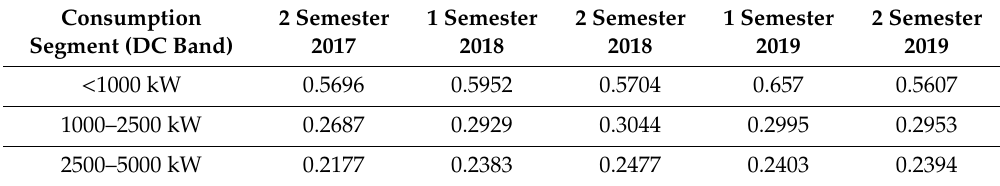
Table 4. Residential electricity prices in Spain ( € / kWh, all taxes and levies included).